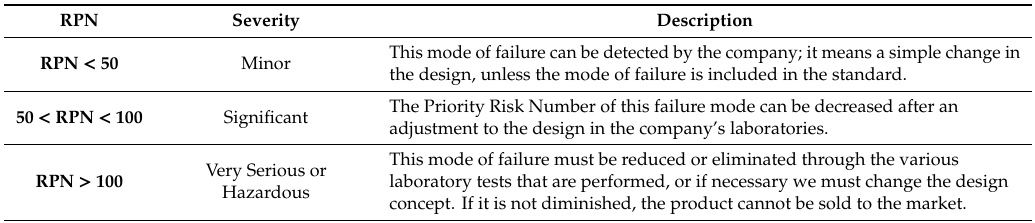
Table 2. Risk priority number (RPN)